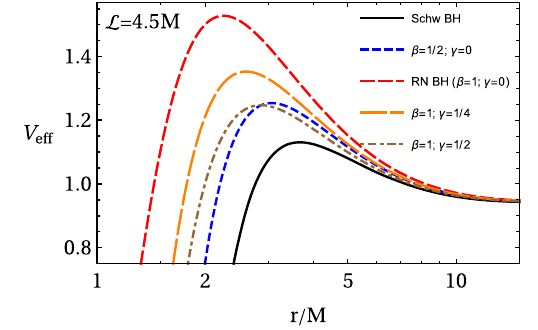
Fig. 3 Profiles of the effective potential for the radial motion of test particles around charged BHs in EMS gravity for various values of the EMS parameters β and γ . In all cases Q = M except Schw